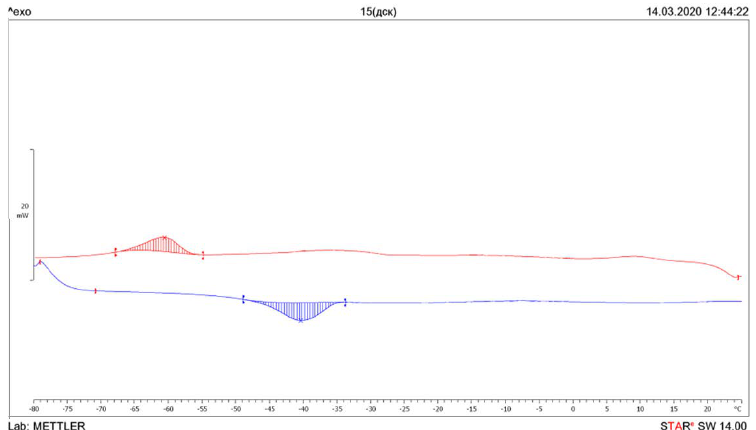
Figure 6. DSC thermogram of the decyl butoxyethyl adipate.